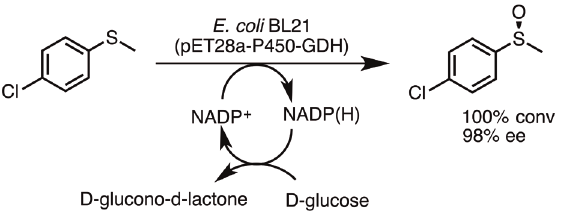
Figure 14 - NADPH regeneration system in the oxidation of para-chloro-thioanisole by recombinant E. coli BL21 (pET28a-